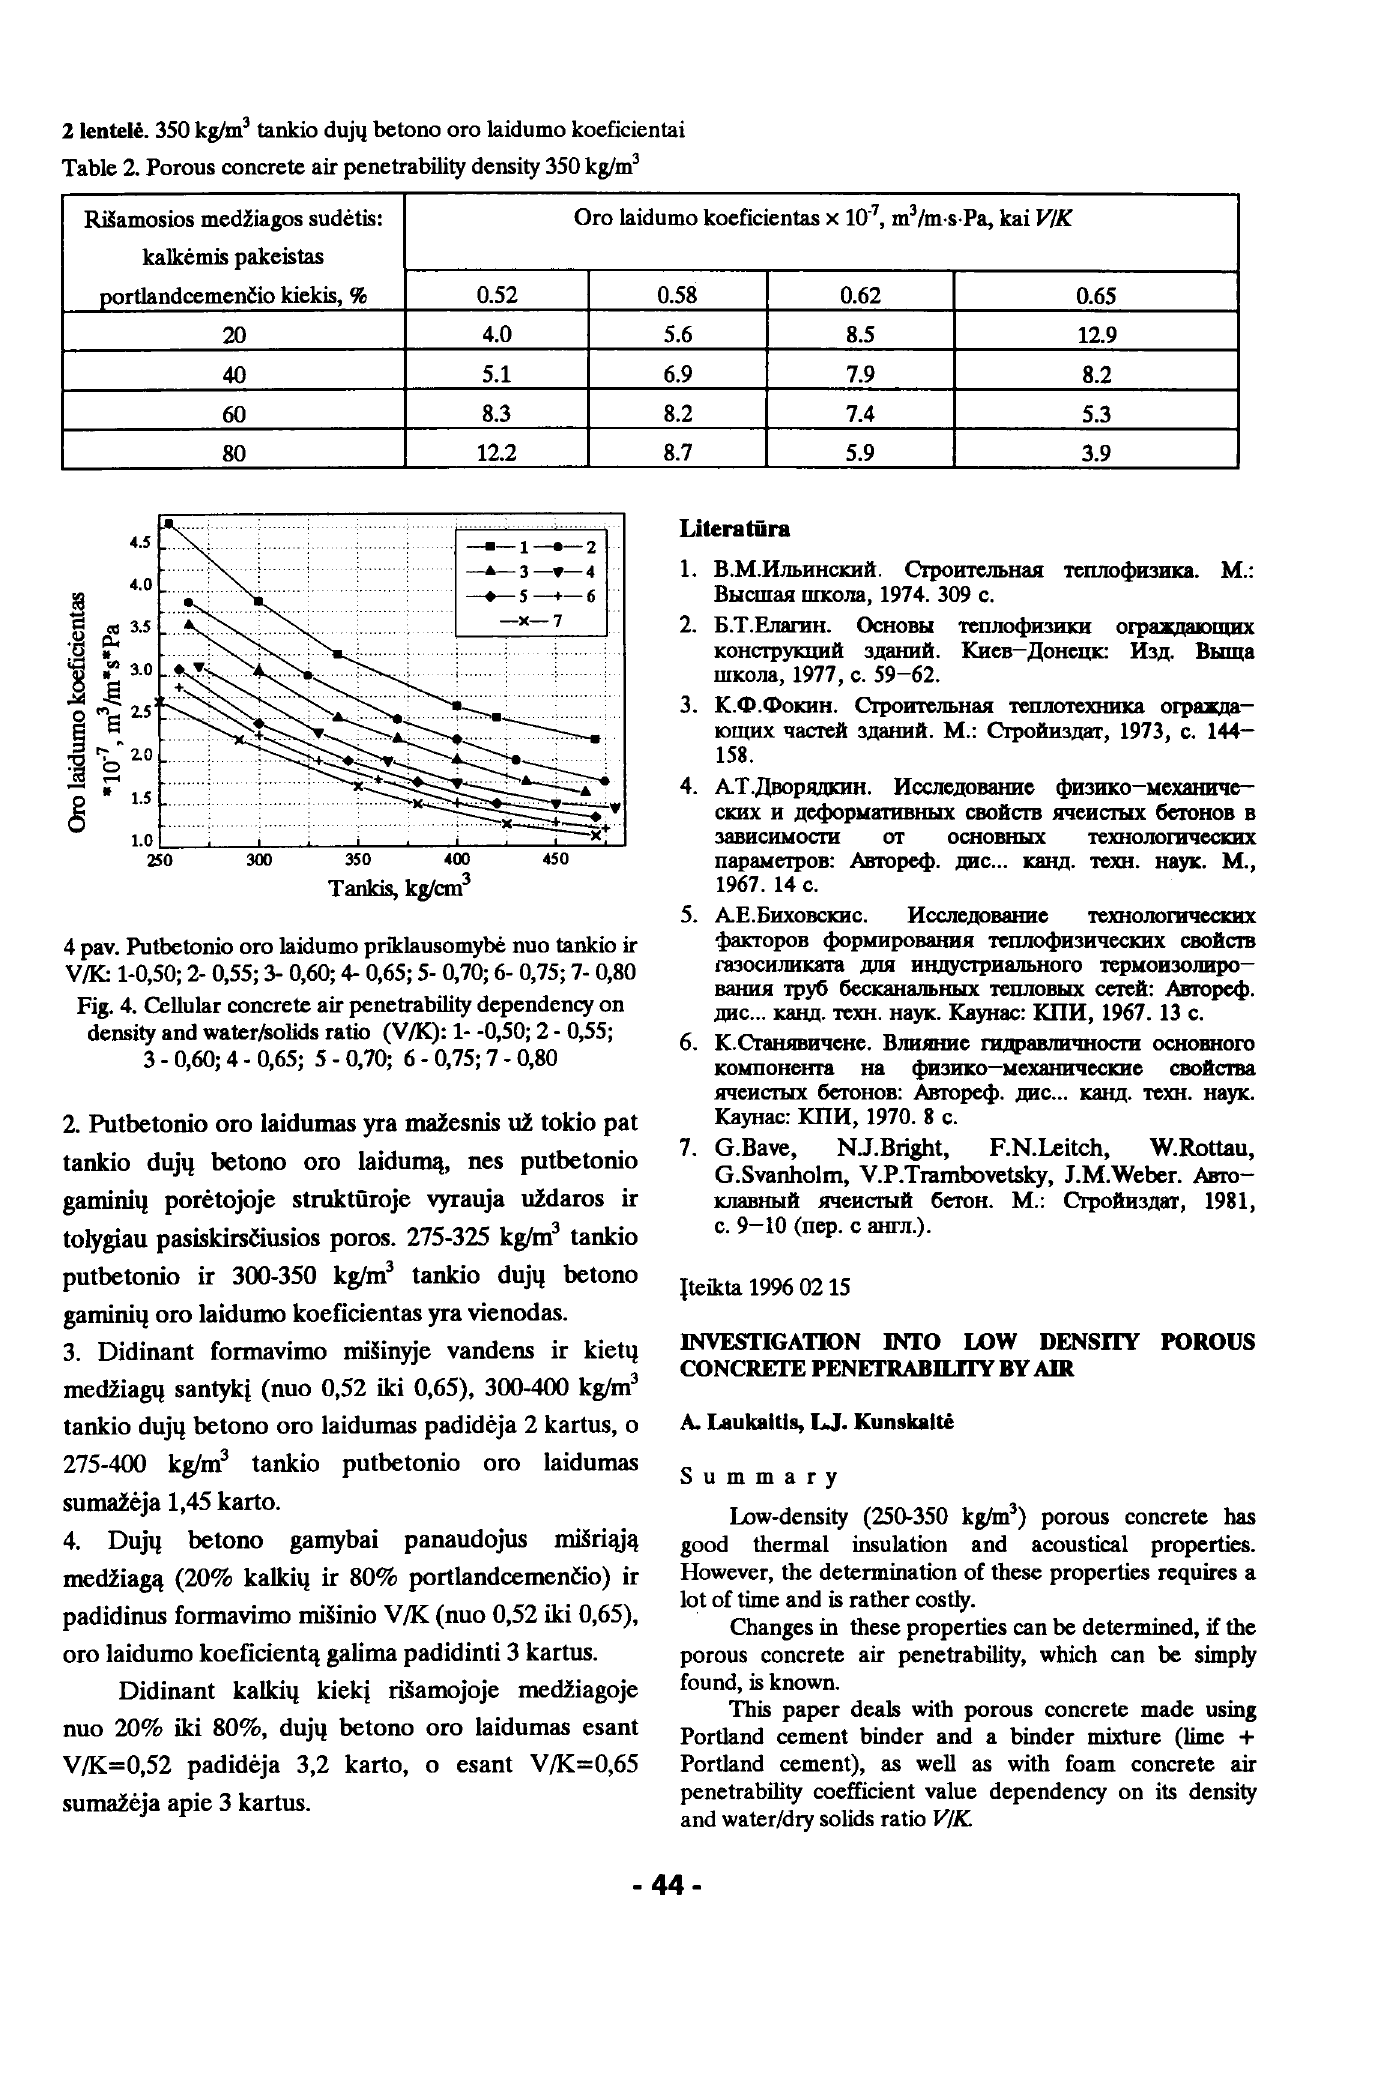
Table 2. Porous concrete air penetrability density 350 kg/m 3